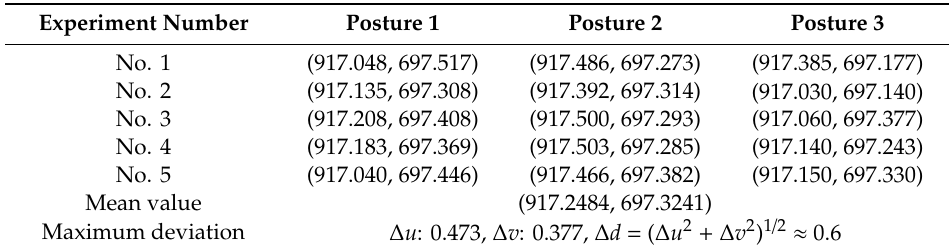
Table 5. The coordinates of the principal point in di ff erent postures of calibration template